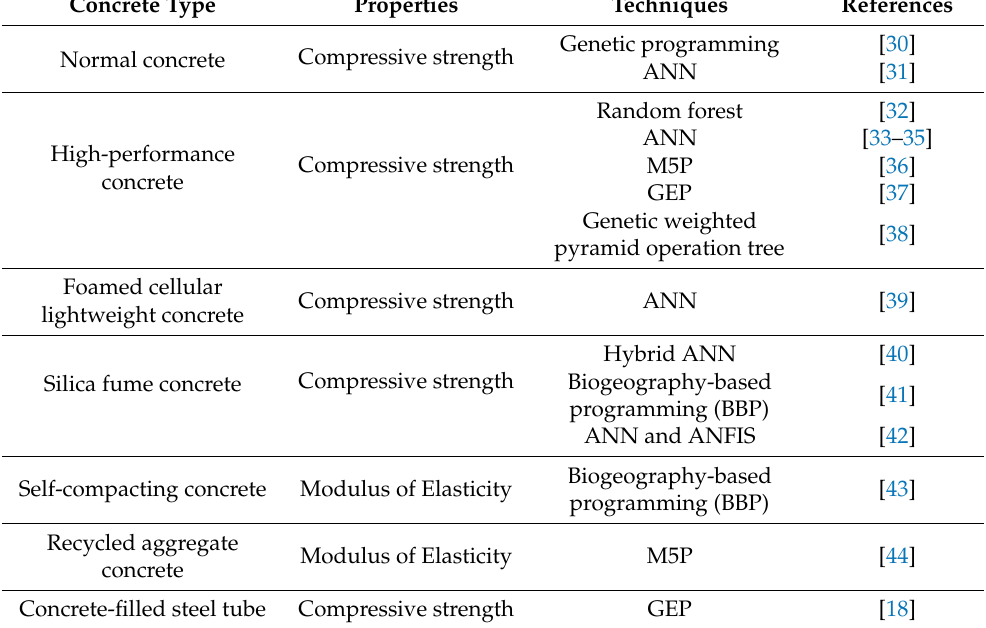
Table 1. Literature-based application of ML